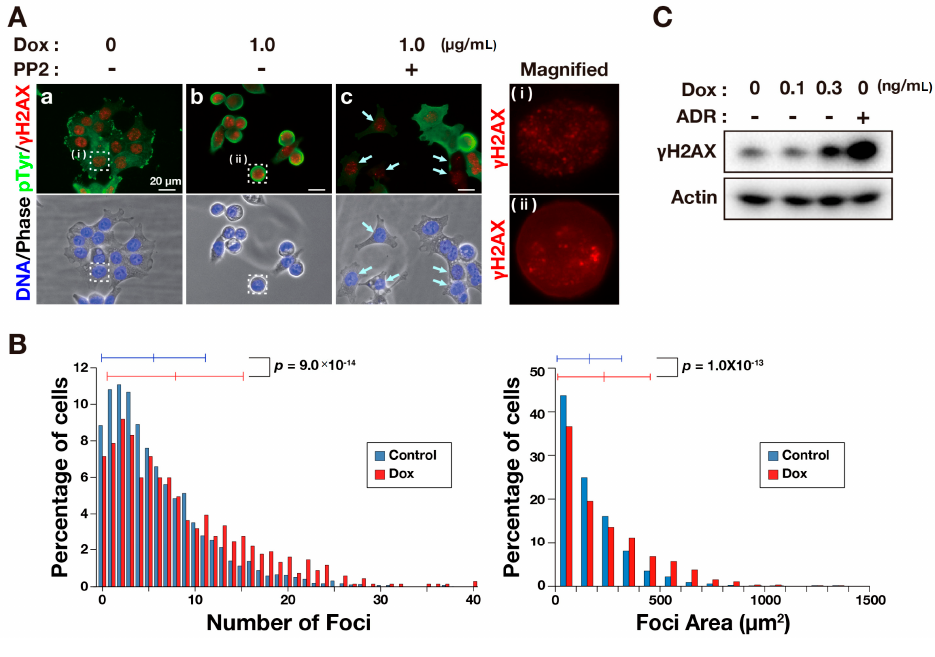
Figure 2. Cont. Figure 2.